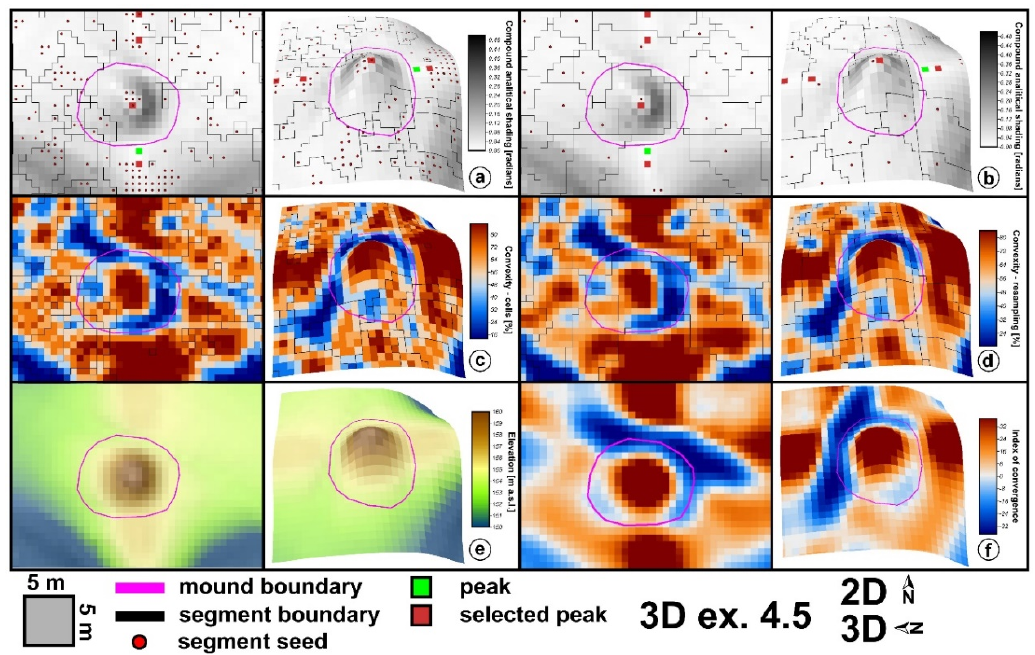
Figure 6. The geomorphometric data for burial mound 64 in 2D (left) and 3D (right): ( a )—peaks, seeds and segments for local convexity computed with cell counting; ( b )—peaks, seeds and segments for local convexity computed with cell count resampling; ( c )—local convexity computed with cell counting; ( d )—local convexity computed with cell count resampling; ( e )—DEM; ( f )—index of convergence. (a high-resolution version can be found at https://doi.org/10.6084/m9.figshare.11798637)